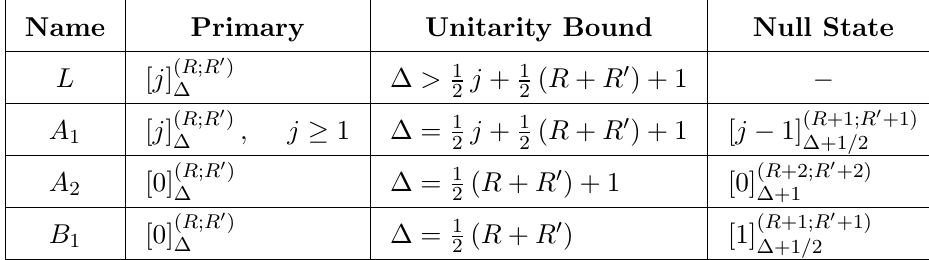
Table 6 . Shortening conditions in three-dimensional N = 4